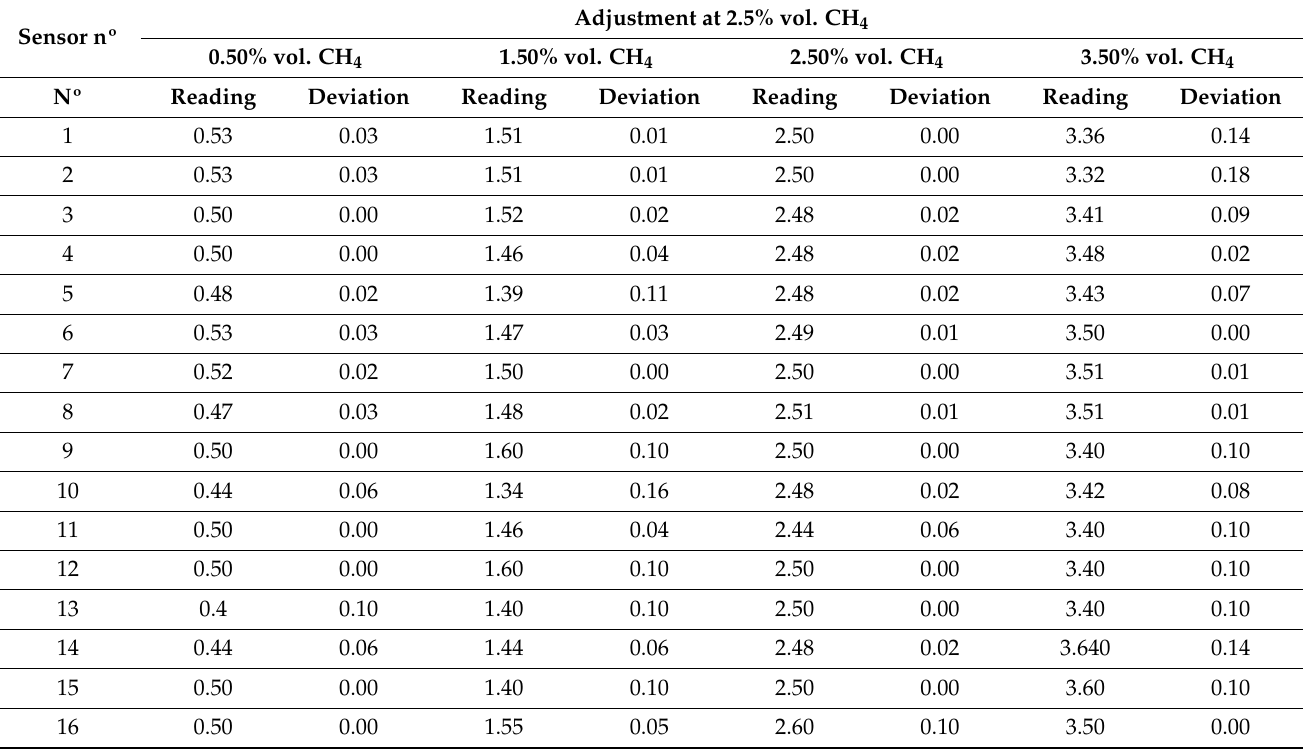
Table 5. Calibration curve—adjustment at 2.5% vol. CH 4 .